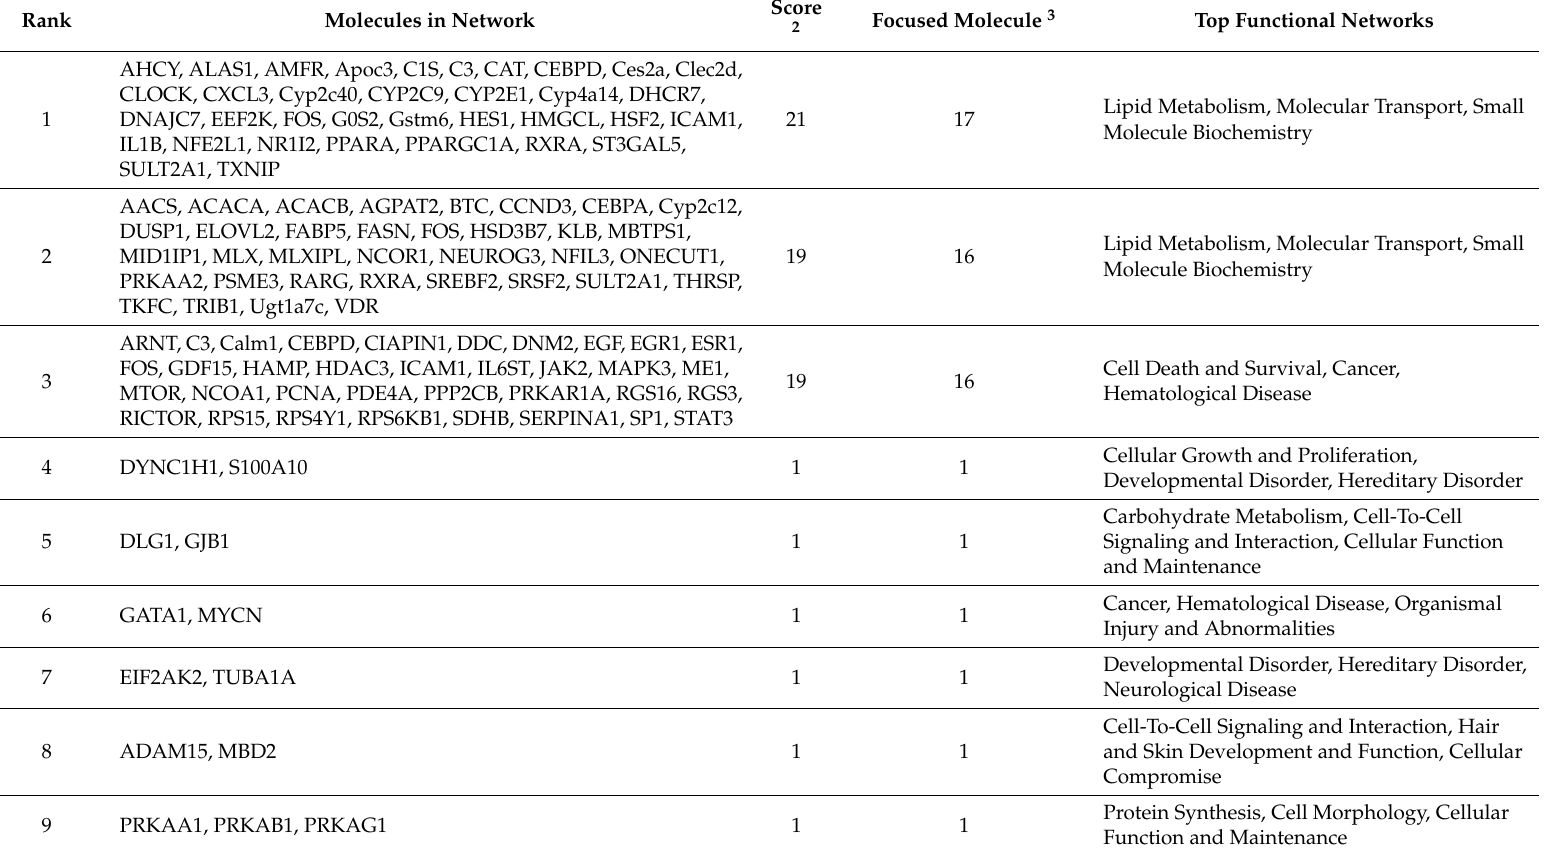
Table 1. Nine networks of di ff erentially expressed genes 1 and their biofunctions predicted by Ingenuity Pathway Analysis (IPA) software.